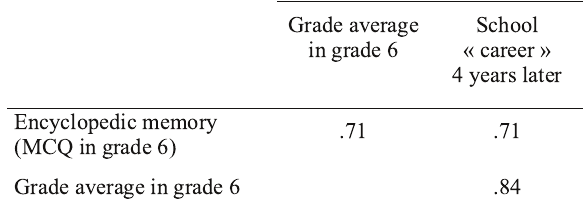
Correlations between grade average and encyclopedic memory at grade 6 and school “career” 4 years later (grade 9), (" =